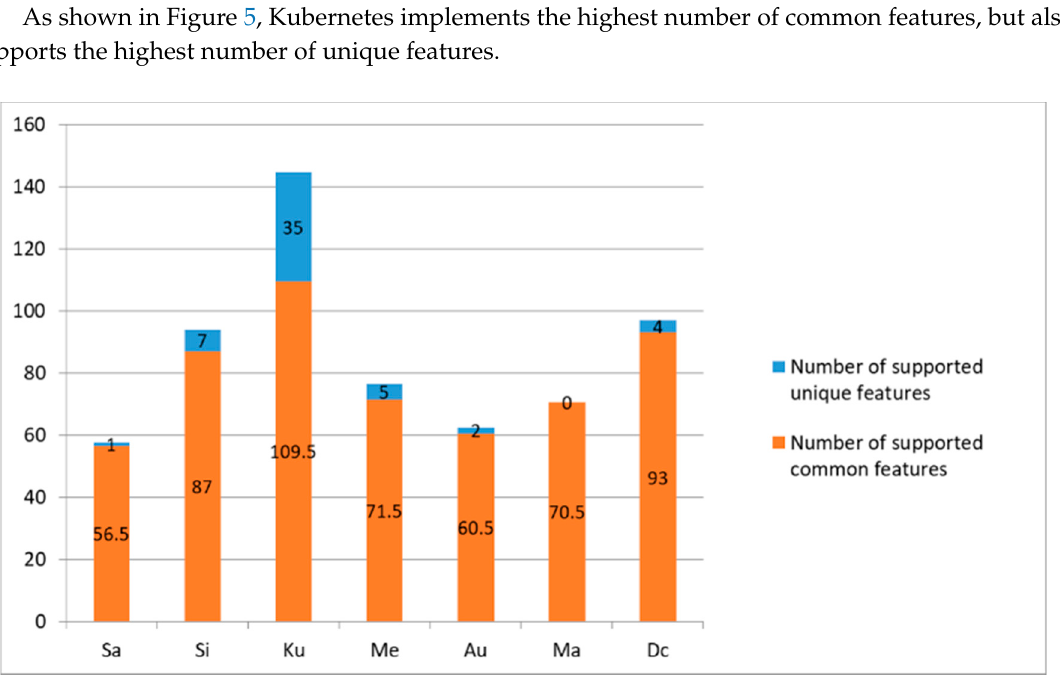
Figure 5. Comparison of CO frameworks according to the total number of supported features. Features that are partially supported by a CO framework or that are only offered by the commercial version of the framework are counted as a ½.